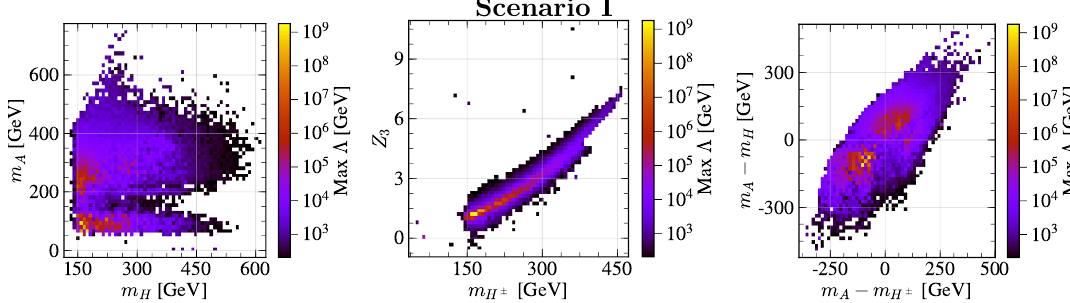
Figure 5 . The maximum breakdown energy scale as function of 1-loop pole masses of scalar masses in scenario I (exact Z 2 symmetry), described in section 4.1. (Left): Higgs masses m H and m A . (Middle): Z 3 vs. charged Higgs mass m . (Right): di(cid:11)erences of masses. H (cid:6)